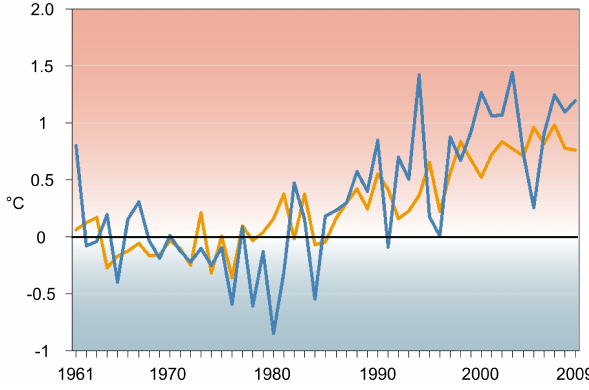
Figure 1. Mean temperature annual anomalies. Italian (blue line) and global land (orange line, data from NCDC / NOAA)